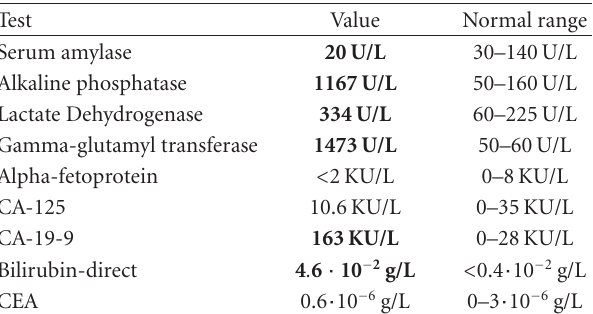
Table 1: Initial blood test values (units/liter and gram/liter), 1KU/L means 10 3 units/liter, bold values are out of